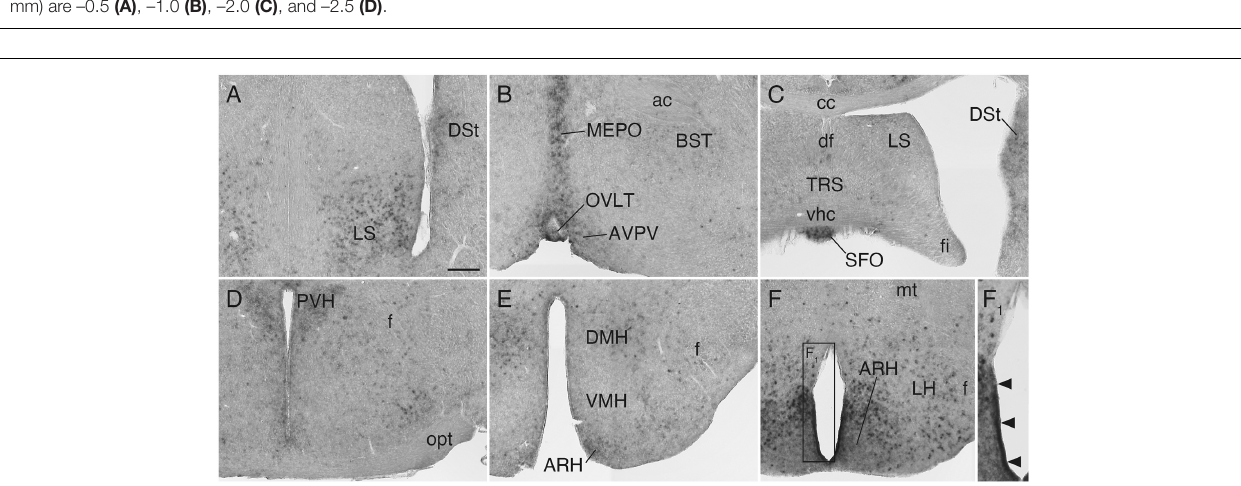
FIGURE 5 | Sulf1 mRNA expression in the septum and hypothalamus. (A,B) Sulf1 was expressed in the ventral part of the lateral septal nucleus (LS), median preoptic nucleus (MEPO), and organum vasculosum of the lamina terminalis (OVLT). (C) Sulf1 was detected in the subfornical organ (SFO). (D–F) In the hypothalamus, Sulf1 was expressed in the paraventricular (PVH), dorsomedial (DMH), and arcuate (ARH) nuclei and in the lateral hypothalamic area (LH). (F 1 ) Shows the enlarged image in the boxed area in (F) . The arrowheads in (F 1 ) indicate strong Sulf1 expression in the cells facing the ventral portion of the third ventricle. ac, anterior commissure; AVPV, anteroventral periventricular nucleus; BST, bed nucleus of the stria terminalis; cc, corpus callosum; df, dorsal fornix; DSt, dorsal striatum; f, fornix; fi, fimbria; mt, mammillothalamic tract; opt, optic tract; TRS, triangular nucleus of septum; vhc, ventral hippocampal commissure; VMH, ventromedial nucleus of the hypothalamus. The scale bars indicate 200 µ m (A–F) and 120 µ m (F 1 ) . Approximate AP levels from the bregma (in mm) are 0.5 (A,B) , –0.5 (C) , –1.0 (D) , –2.0 (E) , and –2.5 (F)